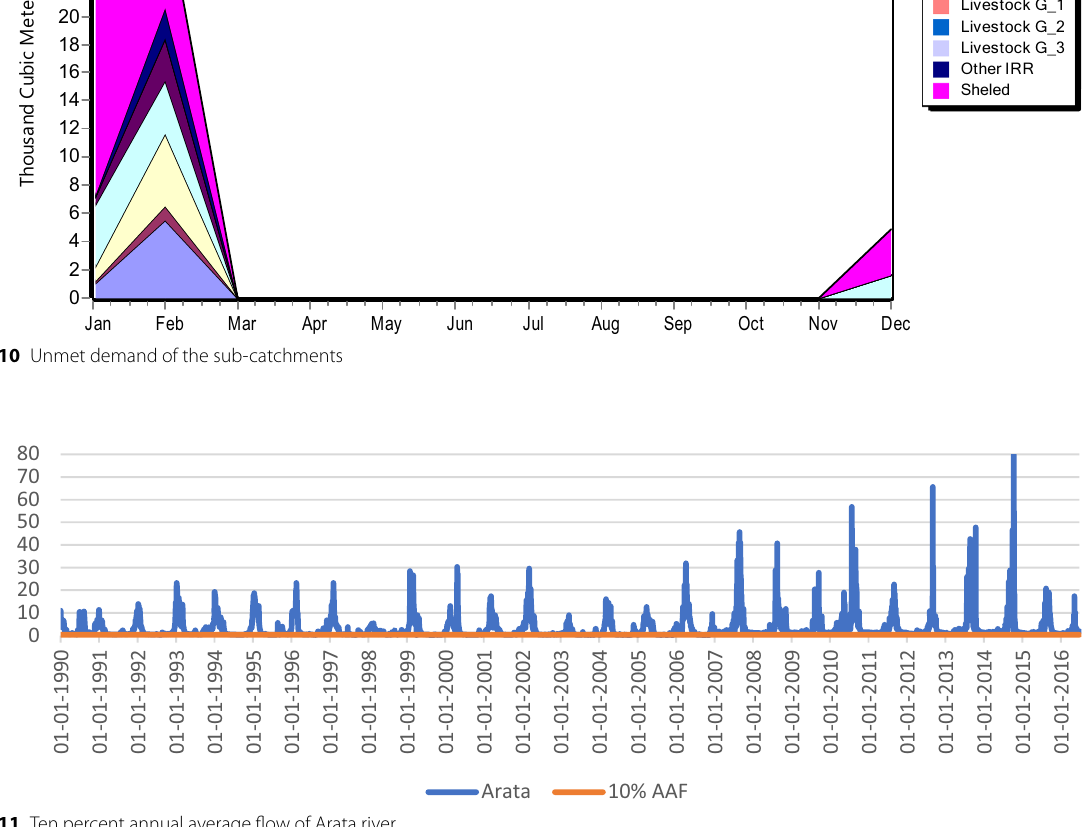
Fig. 11 Ten percent annual average flow of Arata river